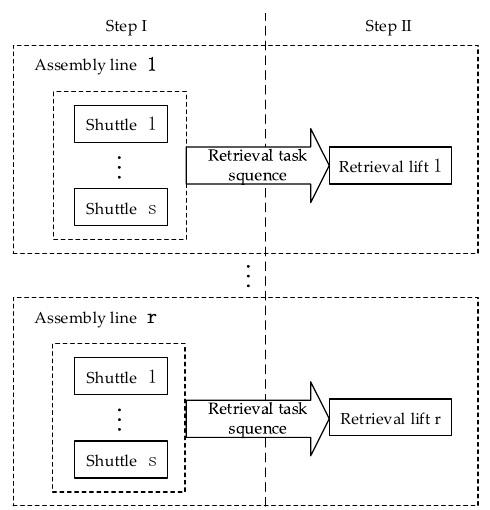
Figure 6. “Production process” of double-deep multi-tier shuttle system.